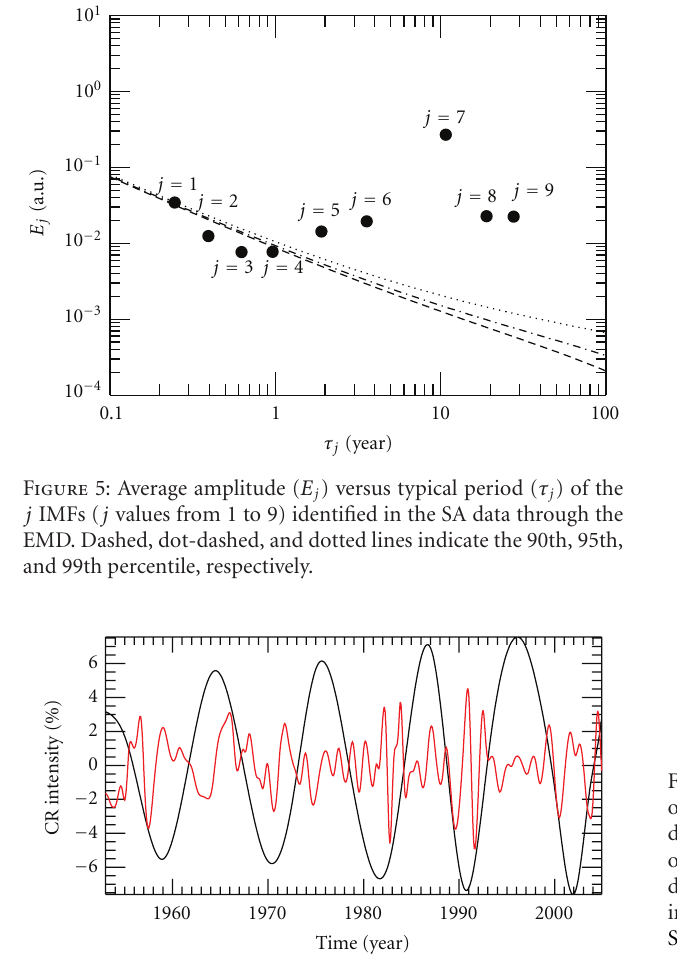
Figure 6: Time history of the QBOs (red line) and the ∼ 11 yr mode (black line) obtained through the EMD for CLI data.